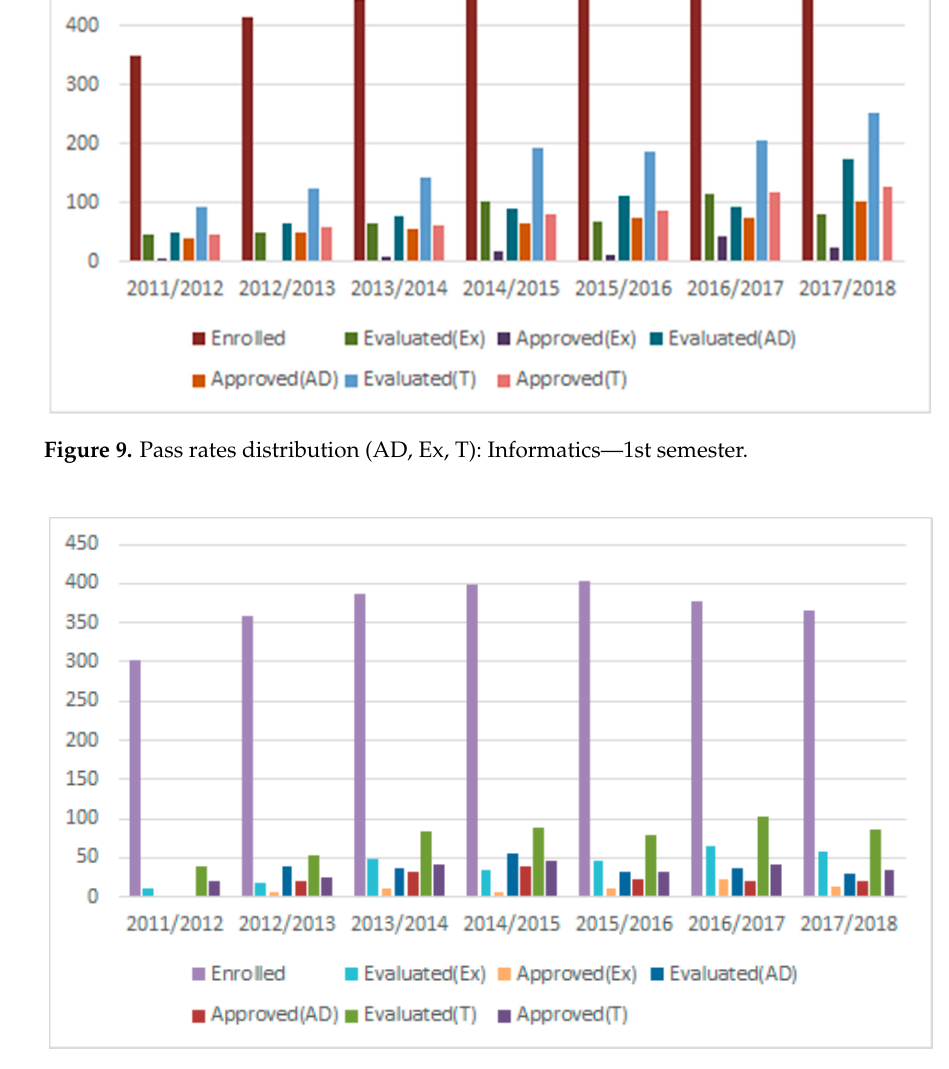
Figure 10. Pass rates distribution (AD, Ex, T): Informatics—2nd semester.